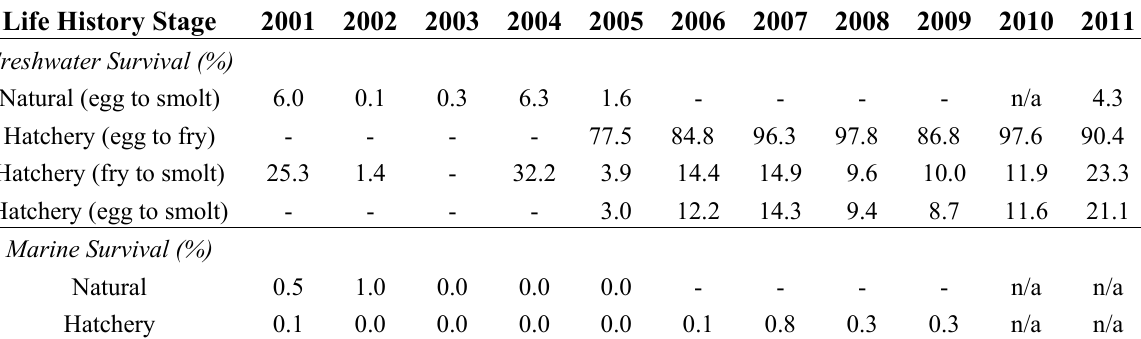
Table 3. Estimates of fresh water and marine survival by broodyear for natural